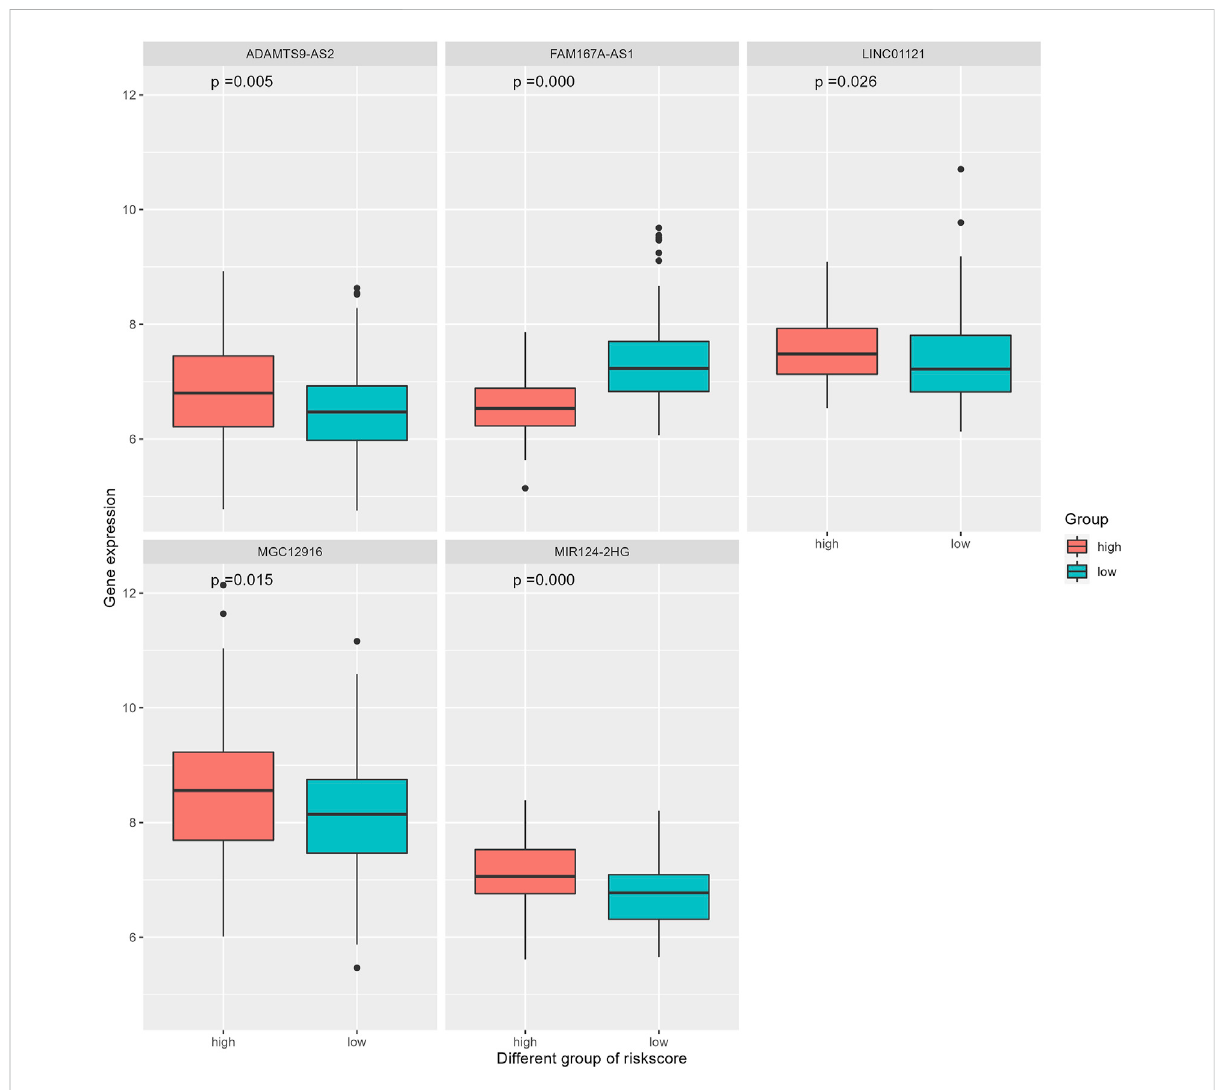
FIGURE 6 Different expression of fi ve ir-lncRNAs between the low- and the high-risk